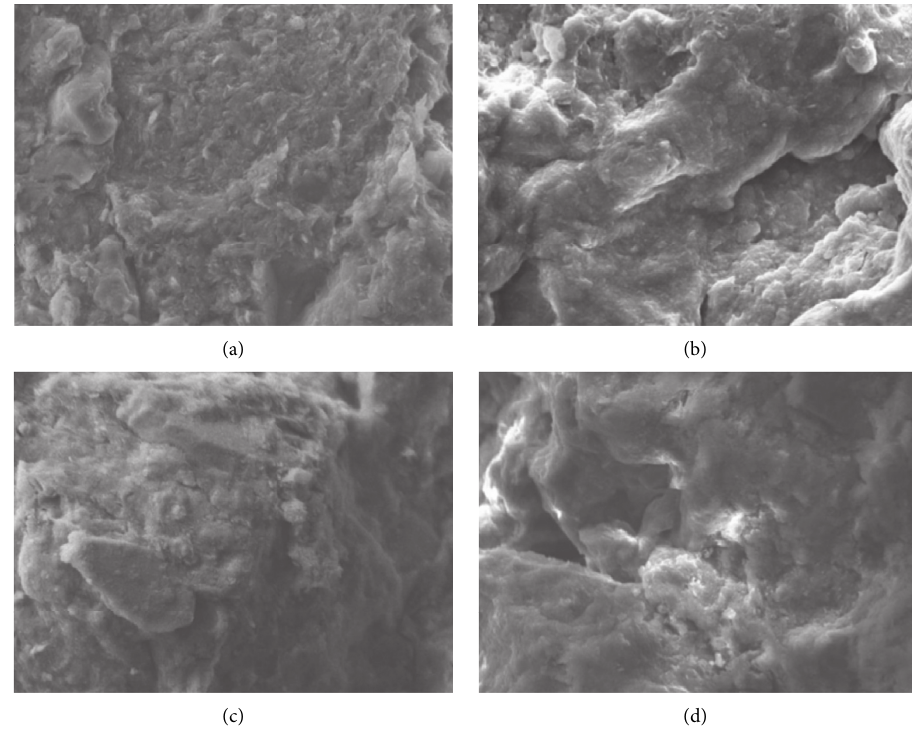
Figure 18: Microcosmicimagesofredclayat1000 ×